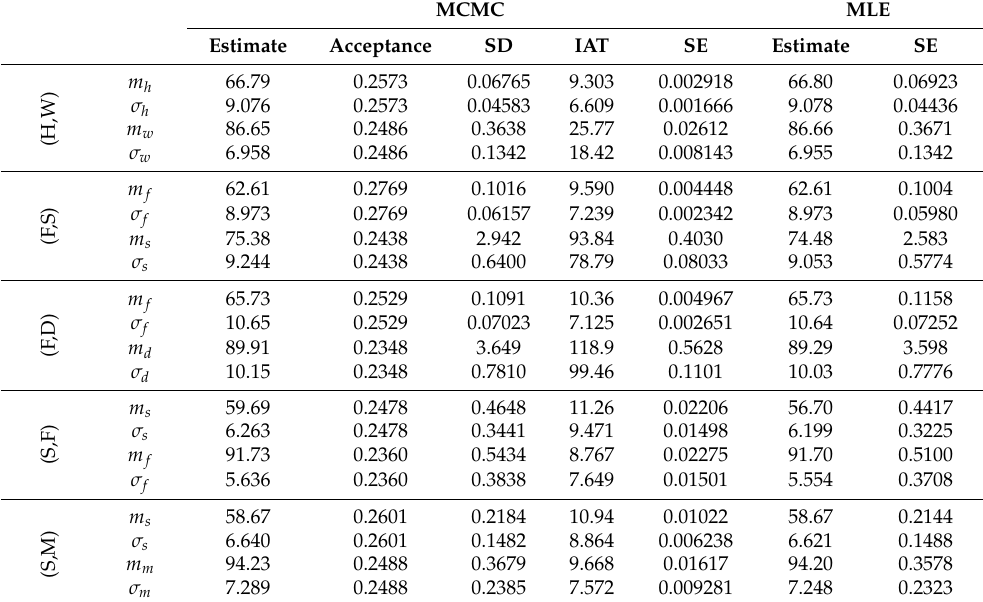
Table 5. Marginal distribution parameter estimation results for all five data sets. MCMC: estimate, acceptance rate, standard deviation (SD), integrated autocorrelation score (IAT) and standard error (SE); MLE: estimate,